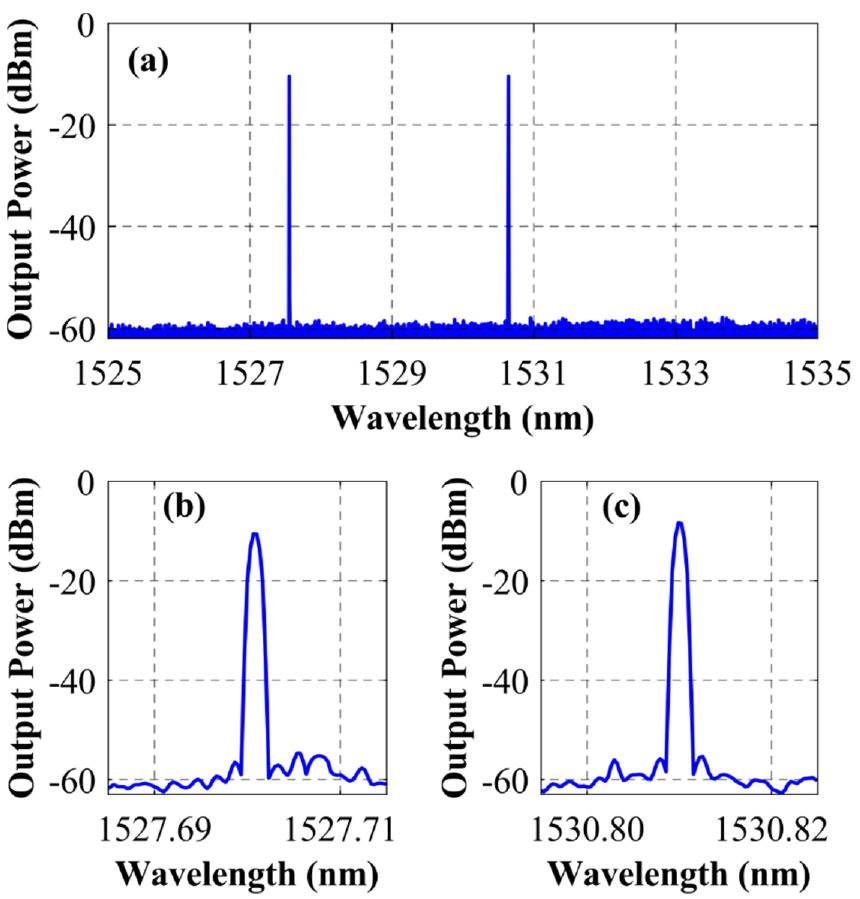
Figure 7. Output spectrum of the fiber laser when pumped at 150 mW and measured by a BOSA–C ( a ), with a detailed view of the 1527.7 nm ( b ) and 1530.81 nm ( c ) emission lines.